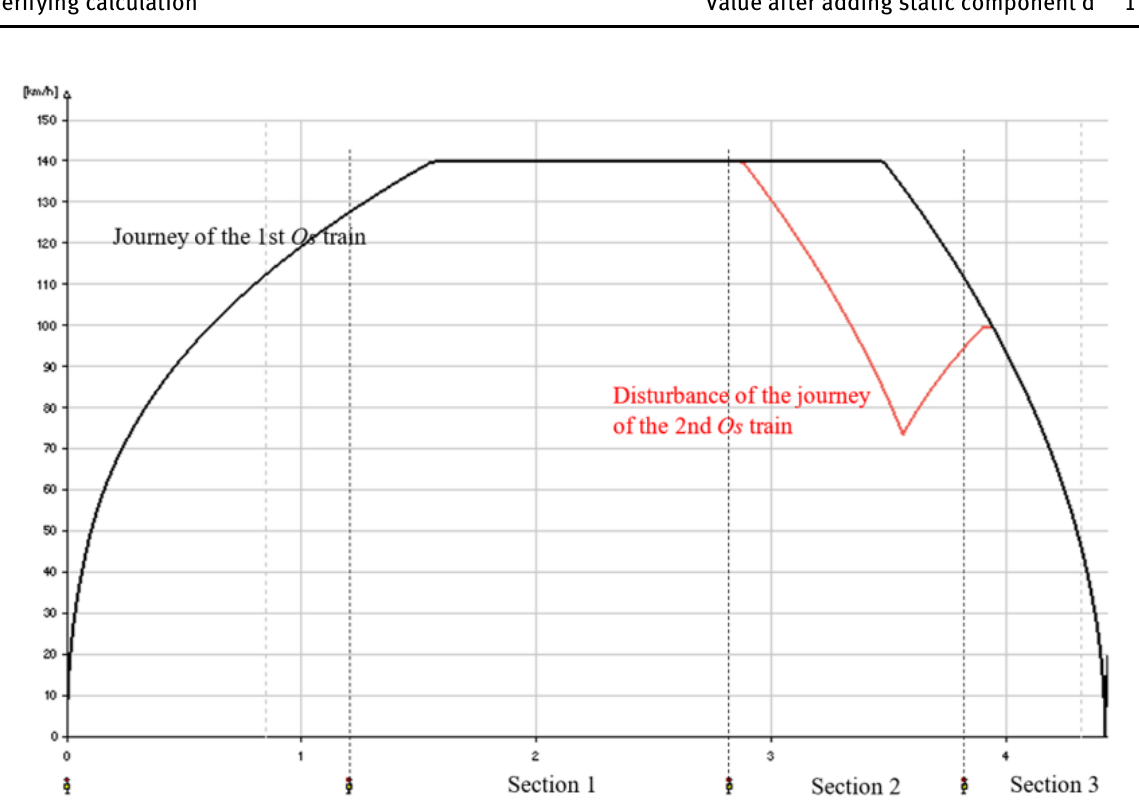
Figure 2: Graph of the journey of subsequent Os trains